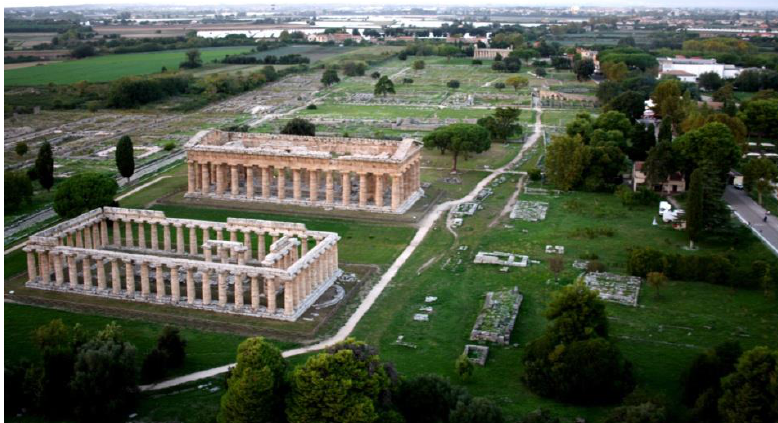
Figure 3. Aerial view of Paestum, looking northwest; two Hera Temples in foreground, Athena Temple in background, the modern museum on right. Copyright © V. Alfano (Source: Own work, CC BY-SA 3.0. https://commons.wikimedia.org/w/index.php?curid=21788866).